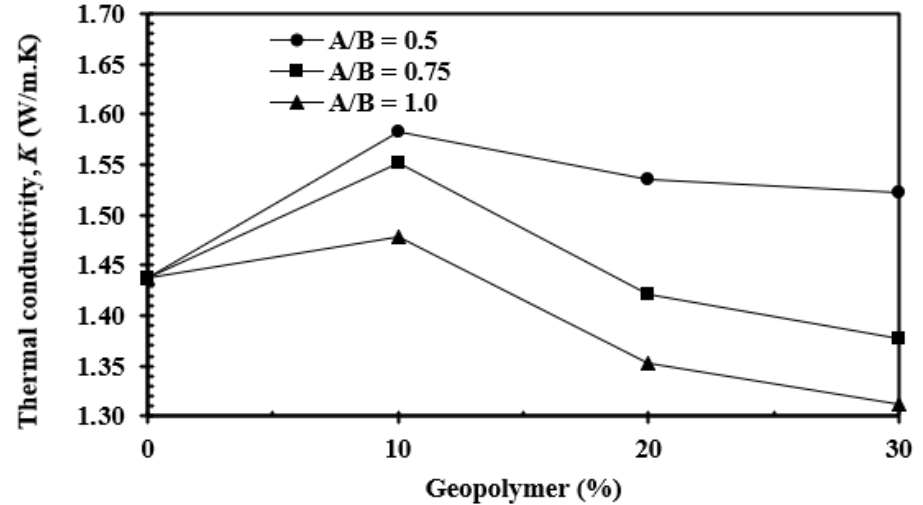
Figure 11. Typical variation of thermal conductivity versus pH at 10% geopolymer content and various A/B ratios.